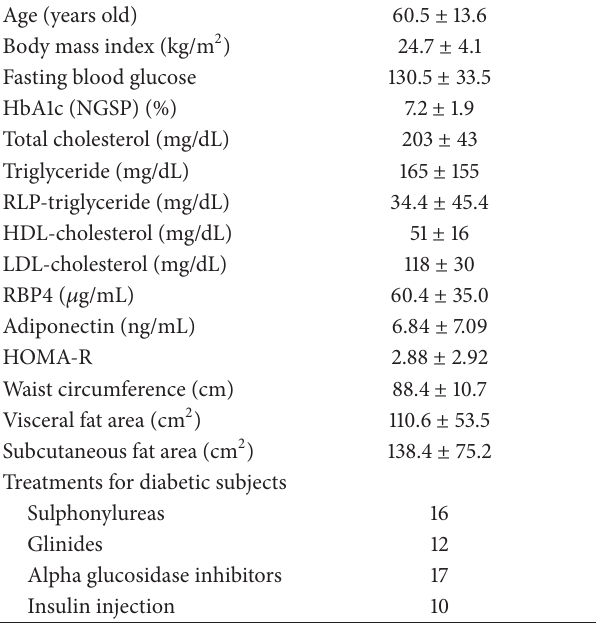
Table 1: Clinical characteristics of the study